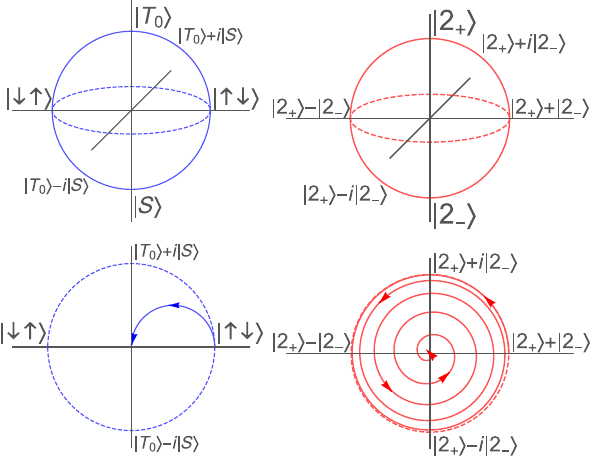
FIG. 1. Top: the Bloch-sphere representation of the spin qubit in the singlet-triplet basis and the valley qubit of the second dot (the first dot will always be in the valley state | 1 + (cid:3) ). Bottom: the time evolution of a state given by Eq. (8) for t ranging from 0 to (cid:2) = 5 J φ = φ π/ J 0 , with 2 0 and 1 2 . The x - y cross sections of the Bloch spheres are plotted since the state stays entirely within the x - y